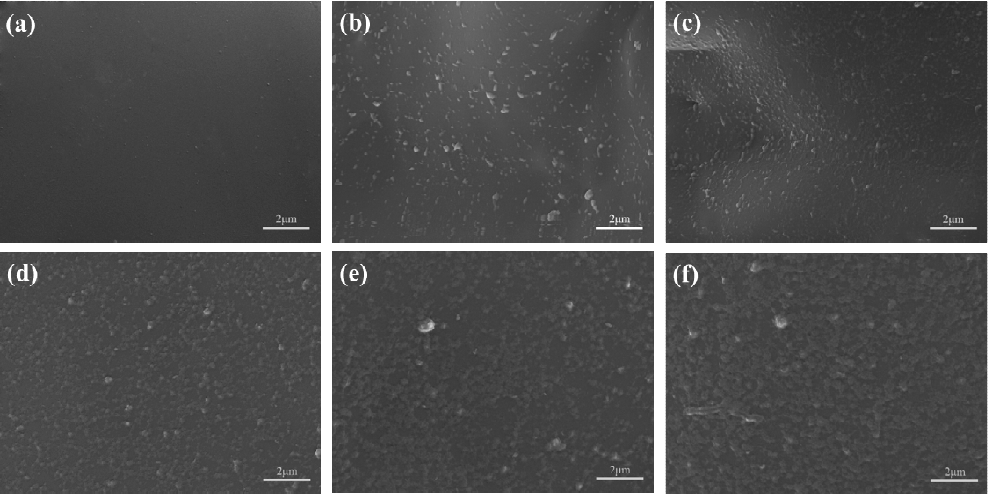
Figure 6. Morphologies of the scaffolds with ( a ) 0 wt %; ( b ) 5 wt %; ( c ) 7.5 wt %; ( d ) 10 wt %; ( e ) 12.5 wt %; ( f ) 15 wt % HAP after immersion in simulated body fluid (SBF) for 14 days.